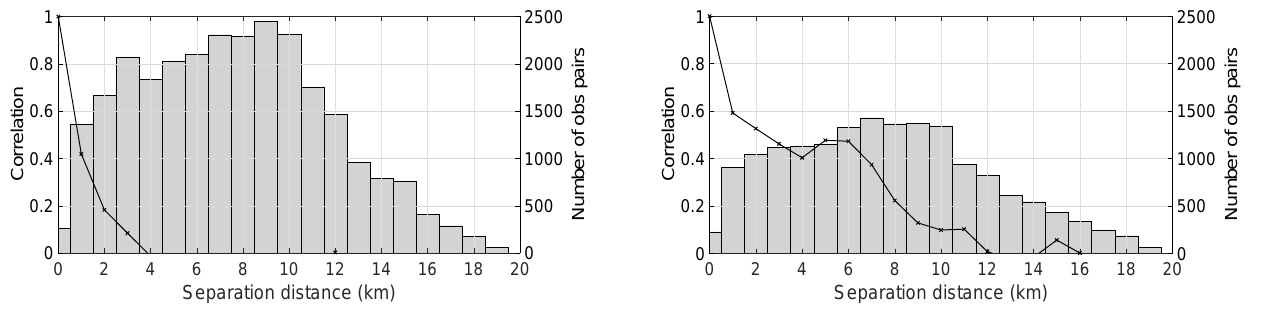
Figure 5. Estimated SAR WLO error correlations (black line) and number of samples (bars) used (bin width = 1km), 27–29 Novem- ber. Estimated error standard deviation is 53cm.